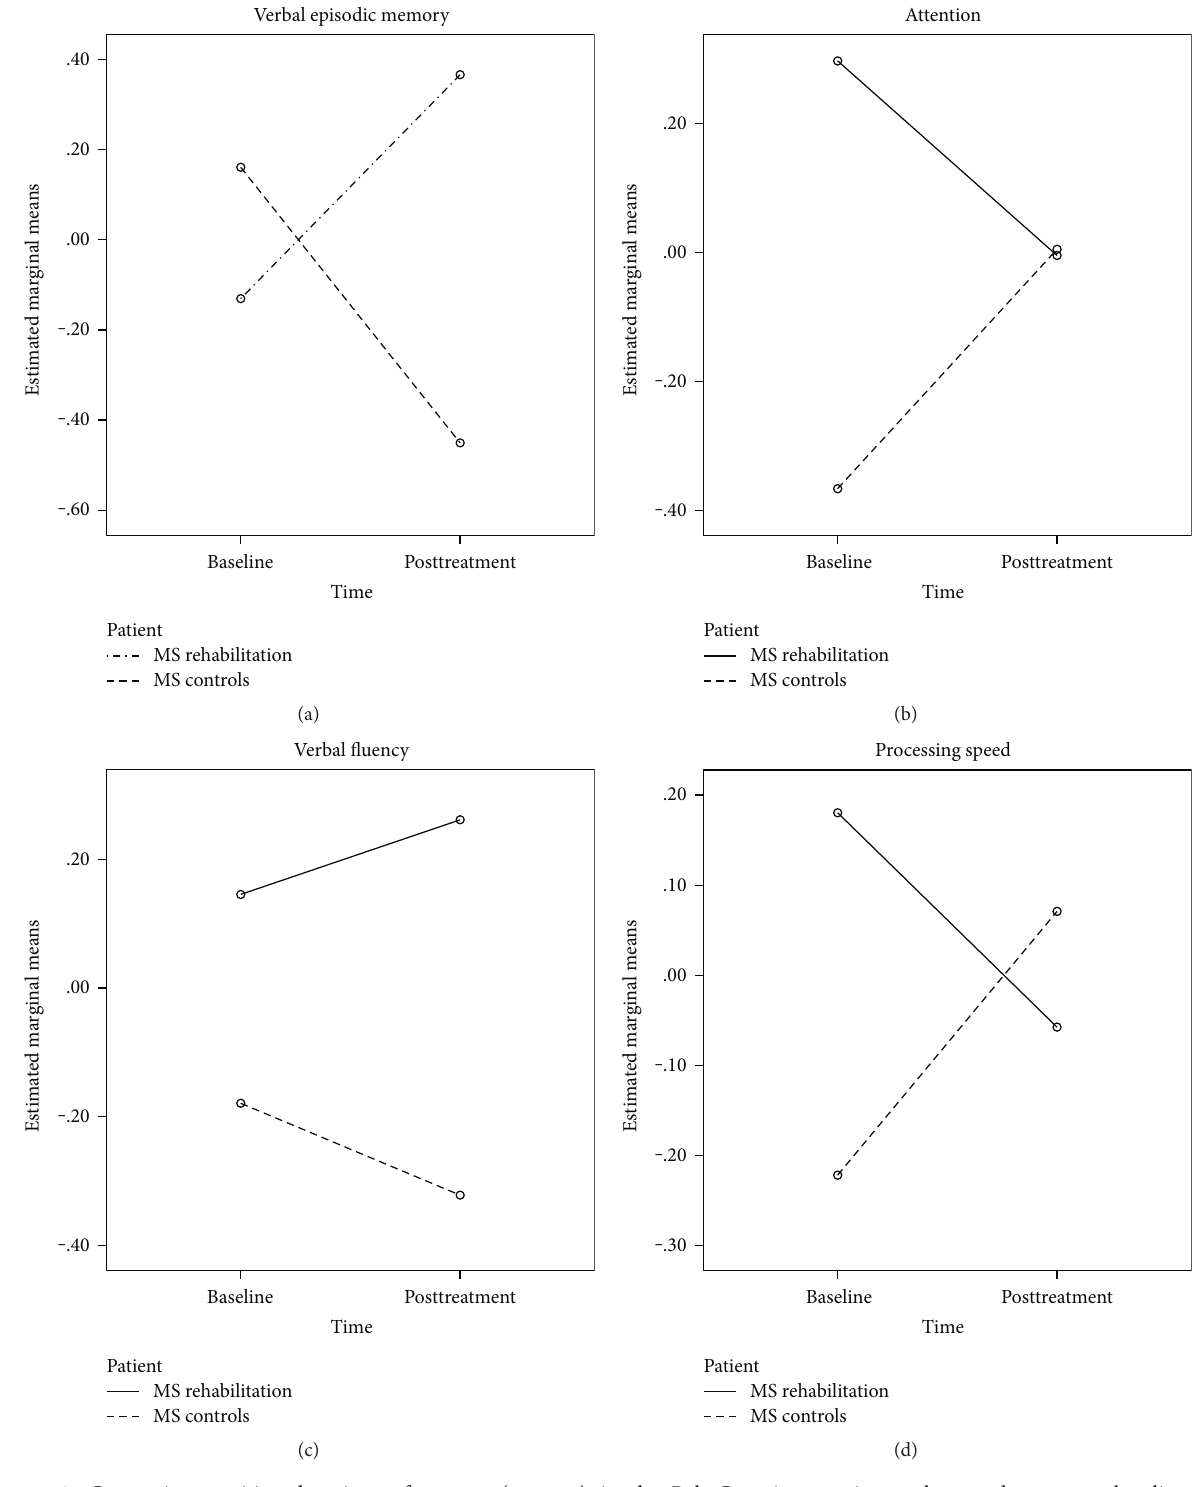
Figure 3: Composite cognitive domain performance ( z -scores) in the RehaCom intervention and control group at baseline and